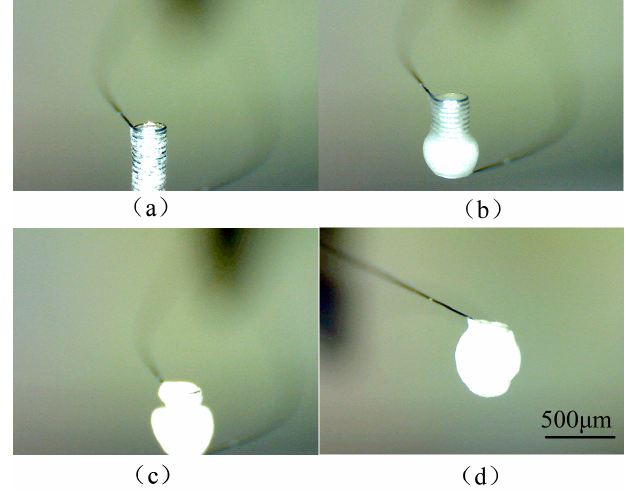
Figure 8. Process of coating Al 2 O 3 suspension onto the platinum coil.